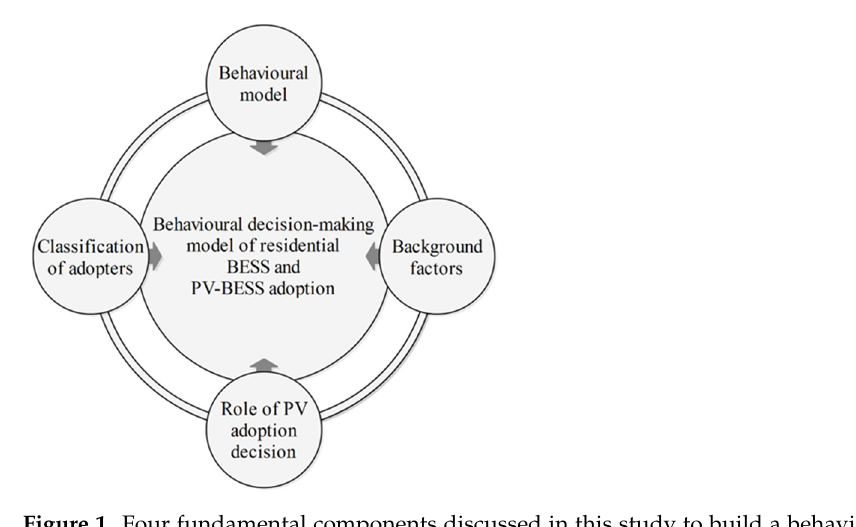
Figure 1. Four fundamental components discussed in this study to build a behavioural decision- making model.